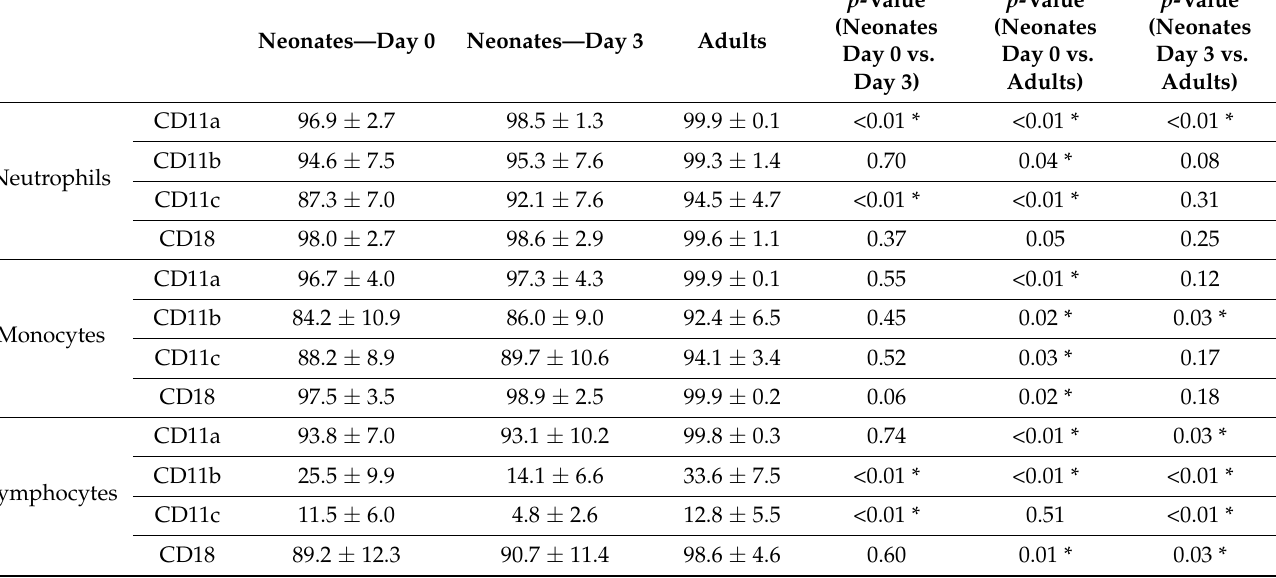
Table 1. β 2 integrin expression on neutrophils, monocytes and lymphocytes in neonates (on day 0 and day 3) and in